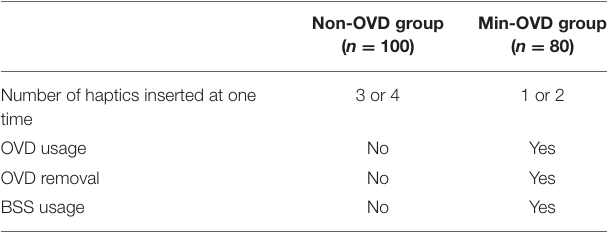
TABLE 1 | Comparison of the two methods of ICL